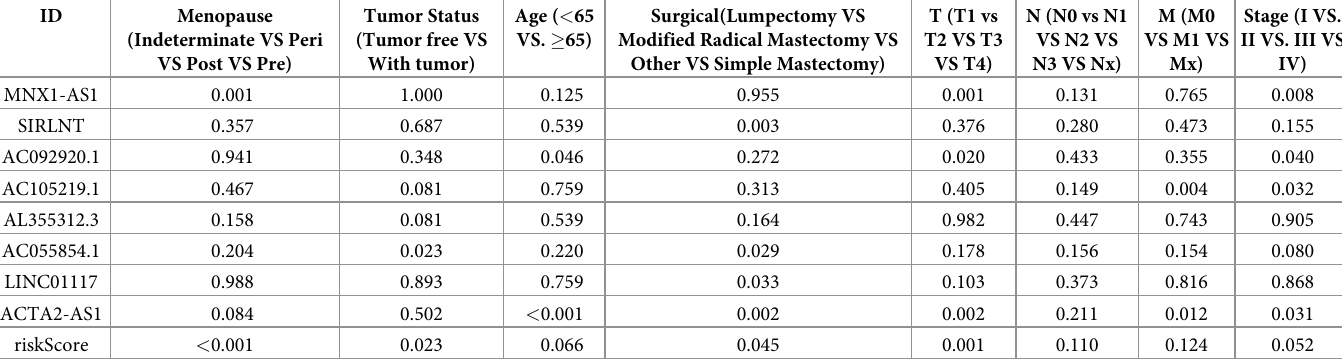
Stage (I VS. II VS. III